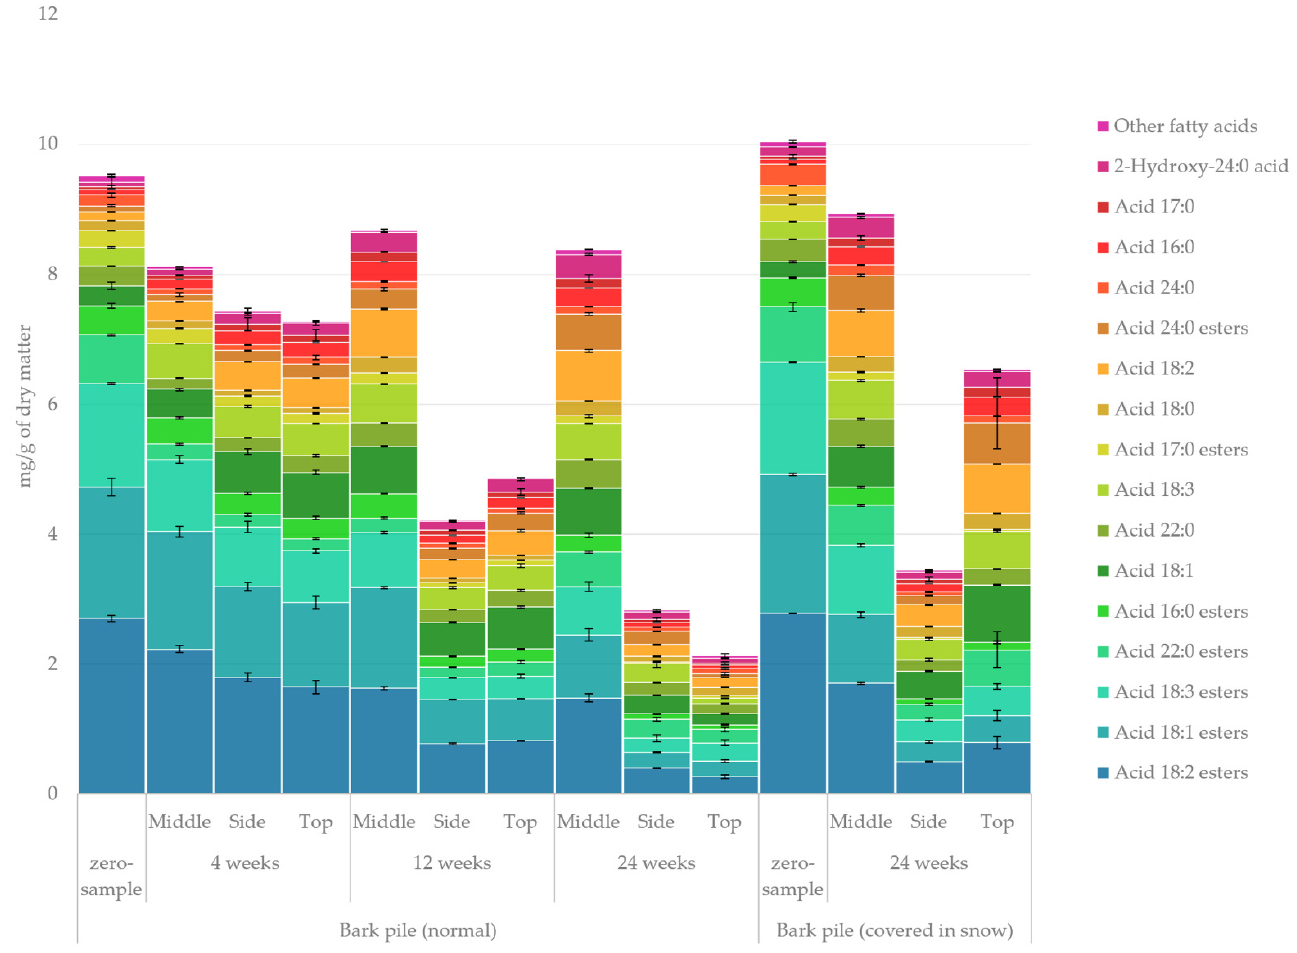
Figure 6. Quantified amounts of individual fatty acids in the lipophilic extracts of stored